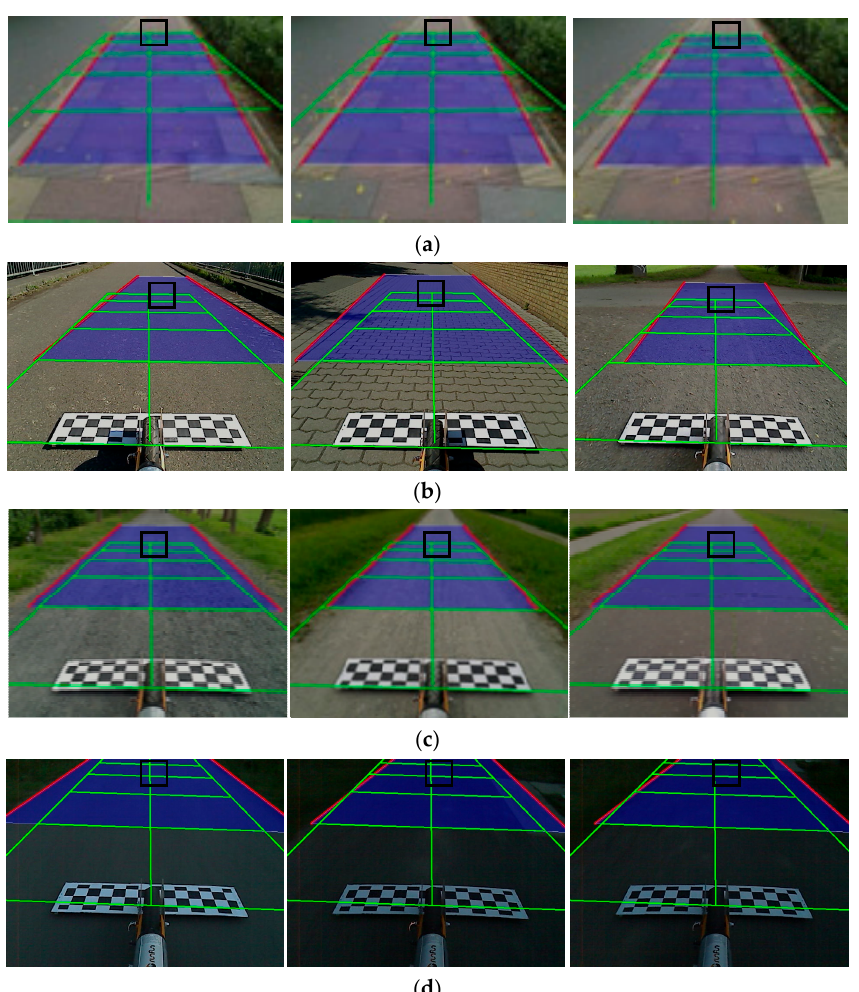
Figure 13. Road detection and target position of sequence frames. Estimated road borders (red). 2 × 5 m grid (green). Road tracking target position (black square). ( a ) Sidewalk; ( b ) Bikeway; ( c ) Parkway; ( d ) Parkway with sunset.